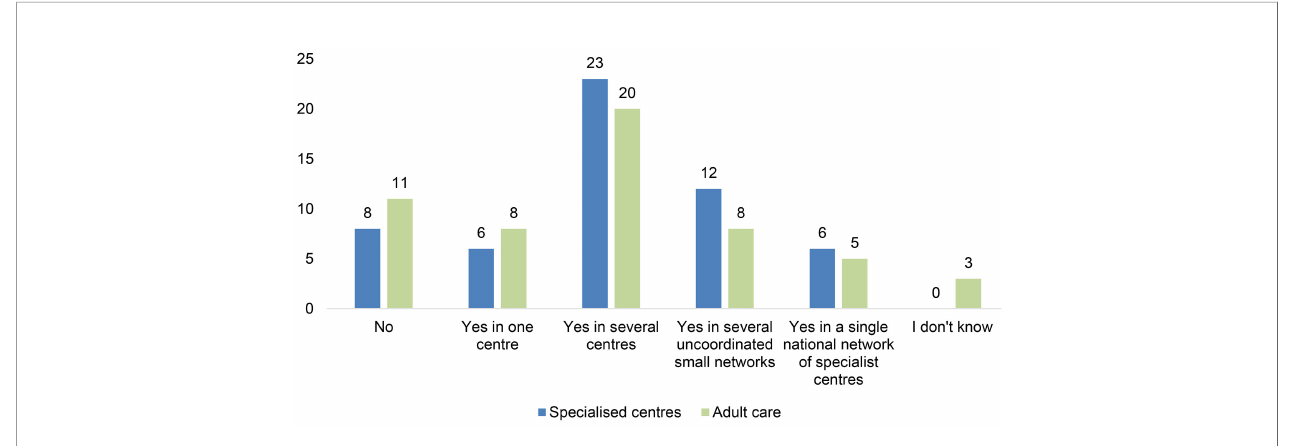
FIGURE 9 | Availability of specialist and adult services for PIDs